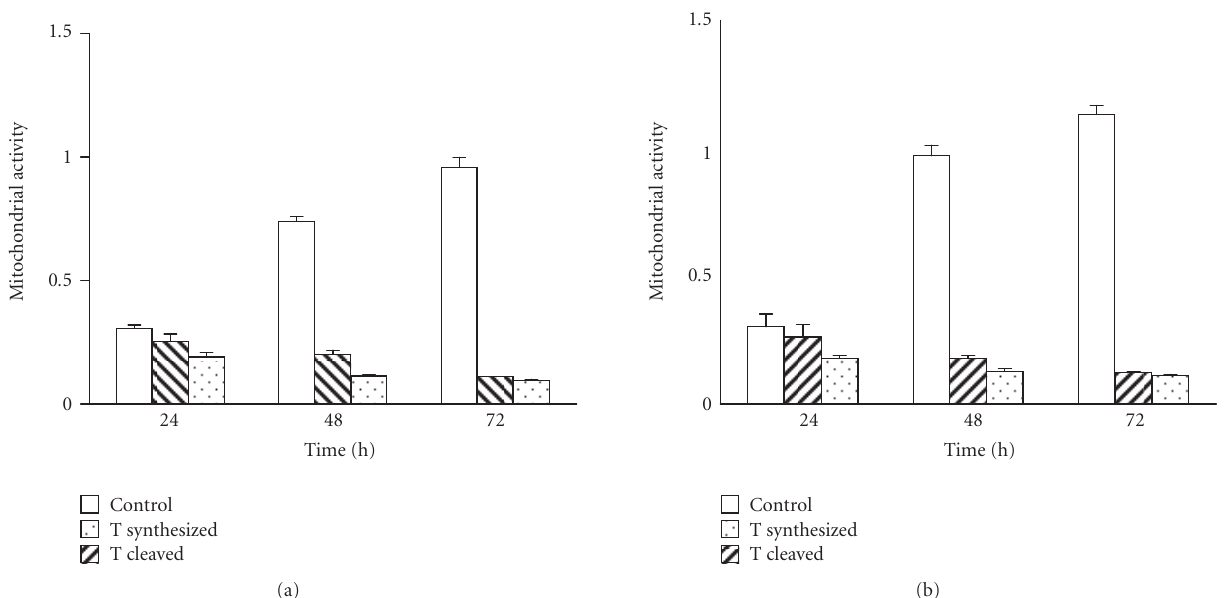
Figure 8: T α 1 (cleaved and synthesized) induced a decrease in the mitochondrial activity in the SPC-A 1 and HepG2 cells. (a) The SPC- A1 cells were treated with the indicated concentrations of T α 1 for 24 hours, 48 hours, and 72 hours. MTT assay was used to measure the mitochondrial activity. Significant decreases in the mitochondrial activity, as compared to the control, occurred after 48 hours of T α 1 treatment. (b) The HepG2 cells were treated with the indicated concentrations of T α 1 for 24 hours, 48 hours, and 72 hours. MTT assay was used to measure the mitochondrial activity. Significant decreases in the mitochondrial activity, as compared to the control, occurred after 48 hours of T α 1 treatment. All the results are expressed as the mean ± SEM of data obtained in 3 independent experiments ( P < . 05, relative to control).